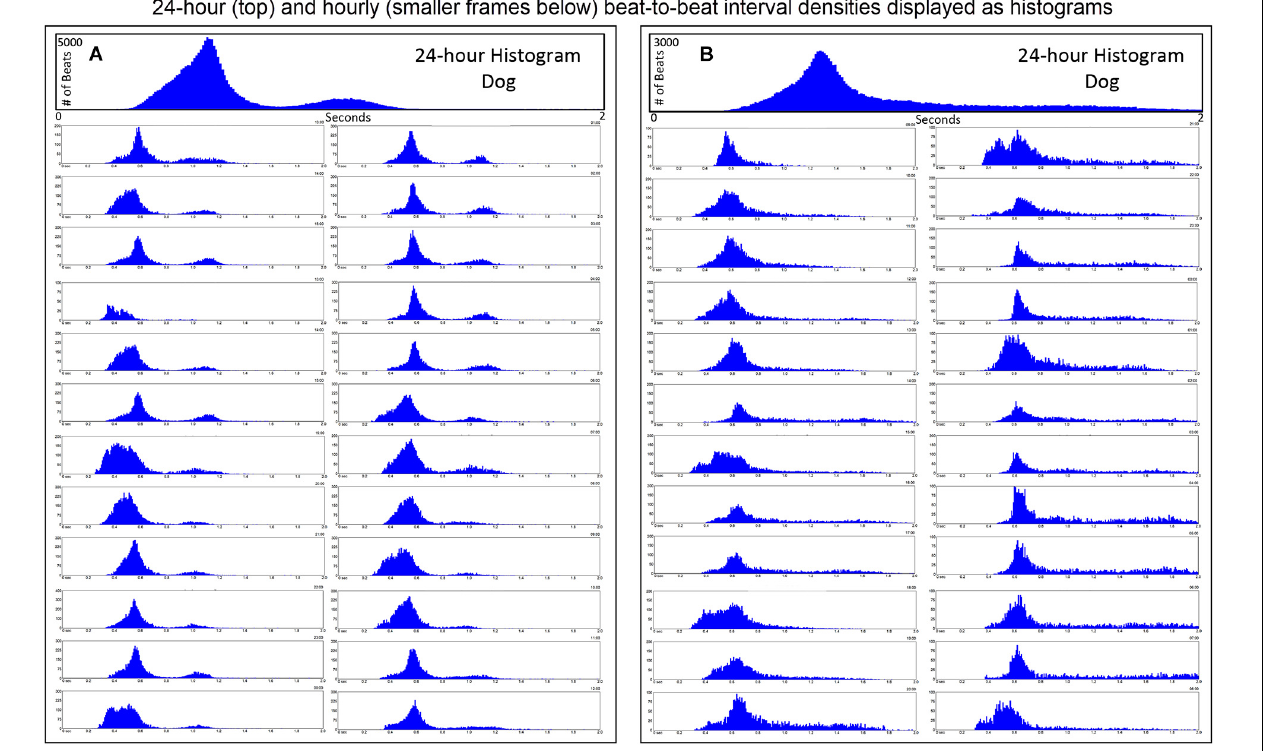
FIGURE 3 | R–R interval histograms from 24-h electrocardiographic recordings from two different dogs. These two dogs represented the basic patterns seen in all dogs. The top expanded frame is the summation of all R–R intervals over the 24-h. Note the different density distribution of R–R intervals (thus, heart rates) in these two examples. Below the 24-h summary frames, the corresponding single 1-h histograms for each dog are shown. The summation of these 24 single 1-h histograms form the composite shown at the top for each dog. Note the more complicated beat distribution of the dog when compared to the human. Dog (A) tends to have different distributions within a given hour. Shorter R–R intervals (more leftward distribution) tend to merge with the dominant distribution centered at approximately 550 ms (109 bpm) with a paucity of beats centered at approximately 800 ms (75 bpm). A small number of beats (but not time spent at these intervals) with the distribution centered at approximately 1050 ms (57 bpm) is seen. Dog (B) has a dominant distribution of R–R intervals centered at 600 ms (100 bpm) with a tail of more diffusely distributed long R–R intervals. Dog (A) was a boxer and dog (B) a Doberman